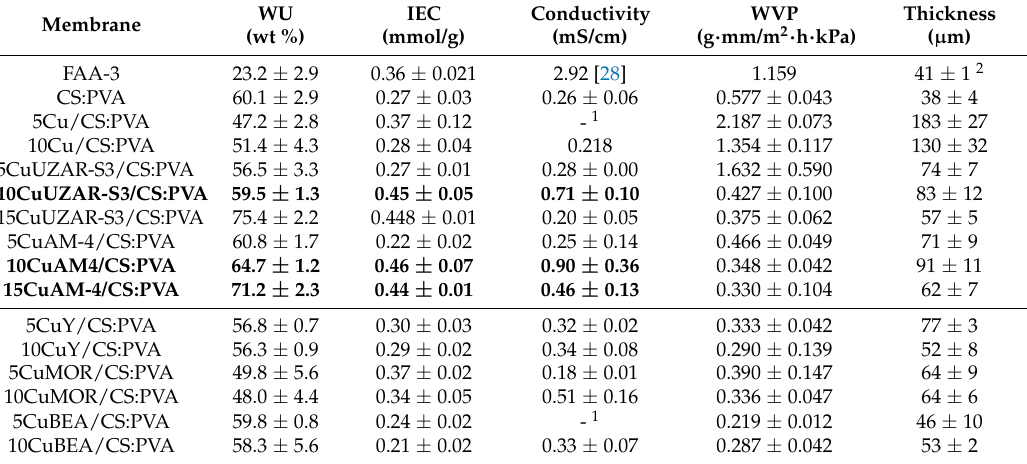
Table 2. WU, IEC, and OH − conductivity, and WVP and thickness of the membranes studied in this